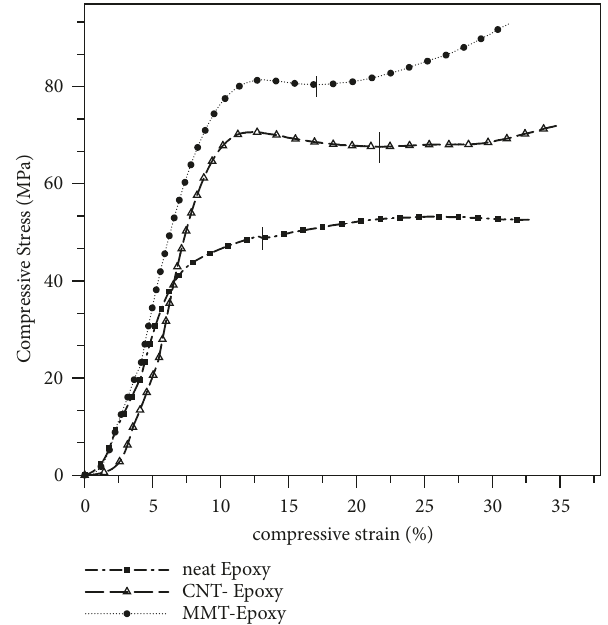
Figure 9: Compressive stress-strain curves of neat epoxy and MMT/SWCNT-epoxy in optimum fraction, conducted at 0.25mm.min - 1 of cross head speed.